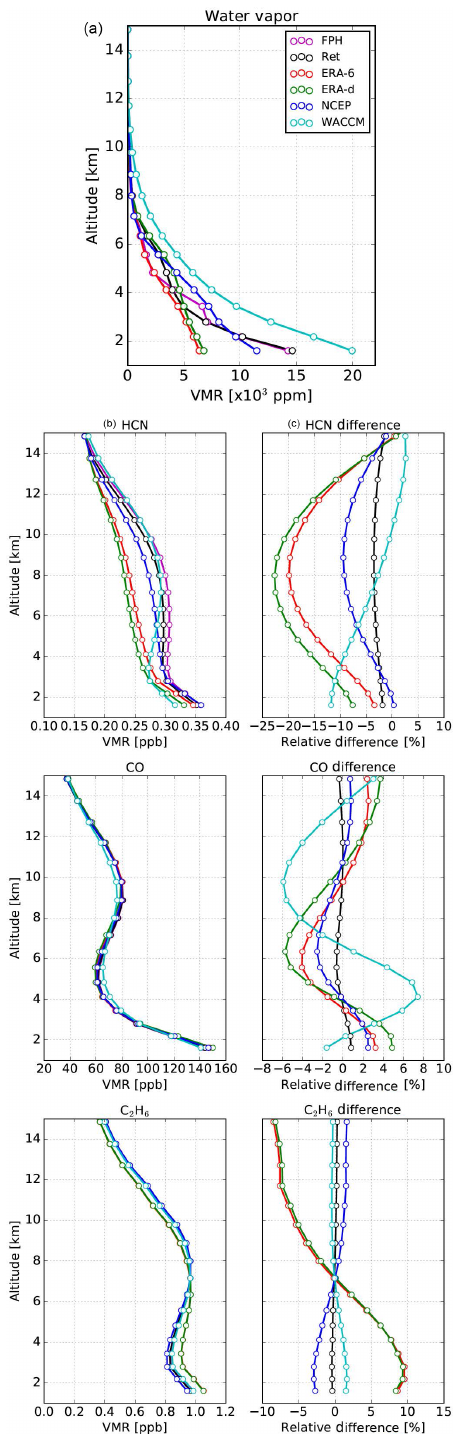
Figure 10. Example on 22 July 2014 of retrieval profiles of HCN, CO, and C 2 H 6 using the different WV a priori sources shown in (a) . The retrieval profiles in (b) and (c) represent the relative difference as a percentage with respect to the retrieval, which uses NOAA FPH